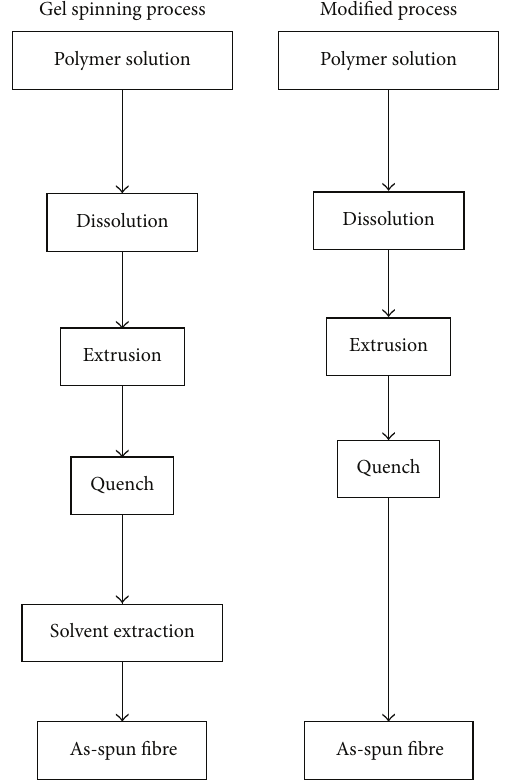
Figure 5: Comparison between conventional gel spinning process and modified gel spinning